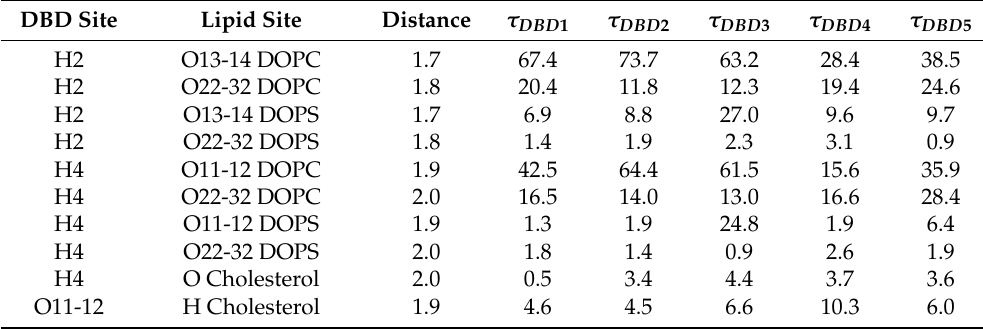
Figure 8. Time evolution of distances between selected sites of DBD3 (‘H2’, ‘H4’) and their partner oxygen sites of DOPC and DOPS. Table 3. Averaged distances (in Å) between selected sites of DBD and the membrane. Continuous time intervals ( τ , in ns) have been obtained from averaged computations along the 600 ns trajectory. Labels as indicated in Figure 1. Estimated errors of ± 0.1 in all